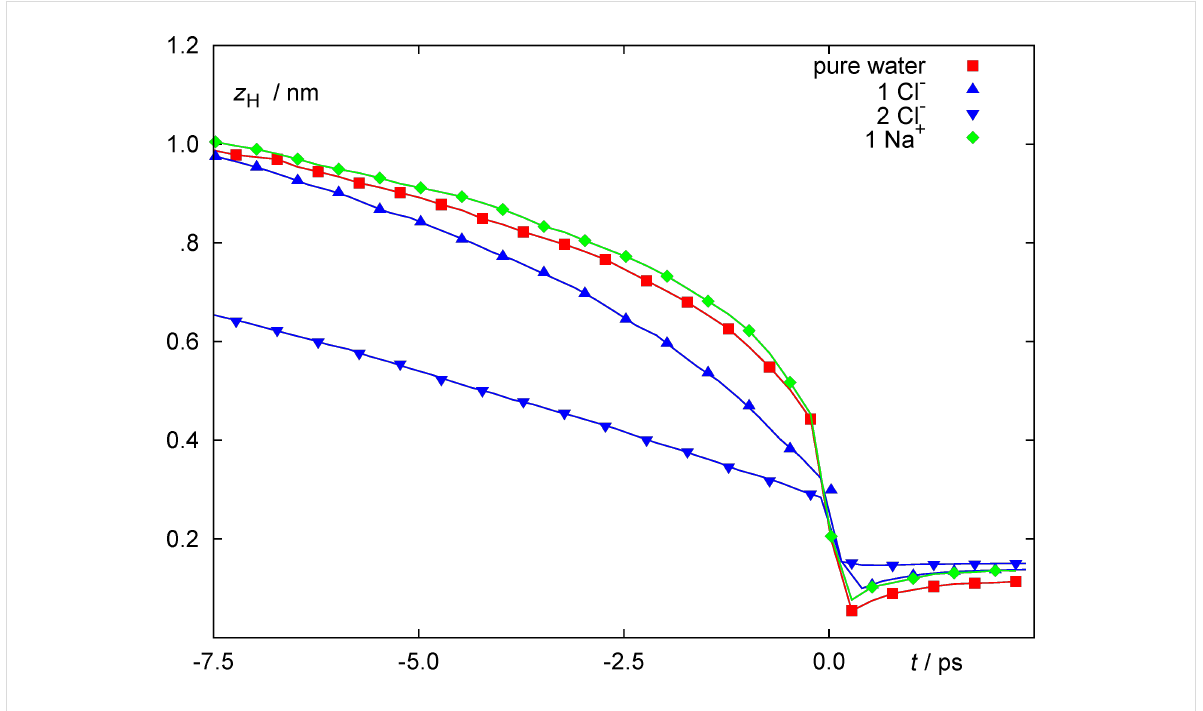
Figure 4: Average proton distance from the metal surface z H as a function of time for pure water (red squares), one or two adsorbed Cl − ions (blue triangles) and one adsorbed Na + (green diamonds). All ions carry a full positive or negative charge. The total surface charge is − 4 e for the Na + system and − 5 e for all other systems. Trajectories are aligned at the time of reaction, which is the zero of time, and